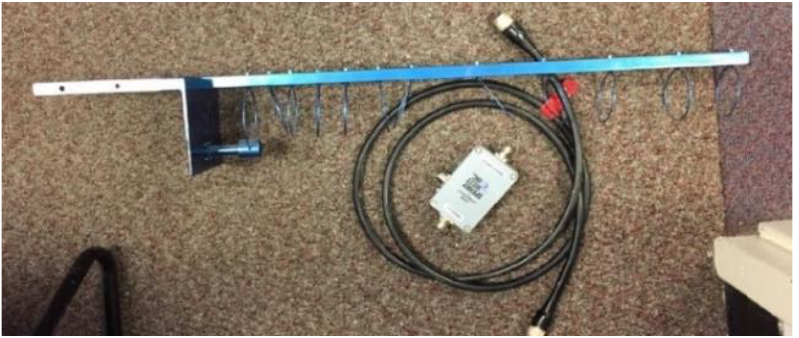
Figure 14. Interfering television amplifier due to poor filtering after removing it. (courtesy of FCC United States).